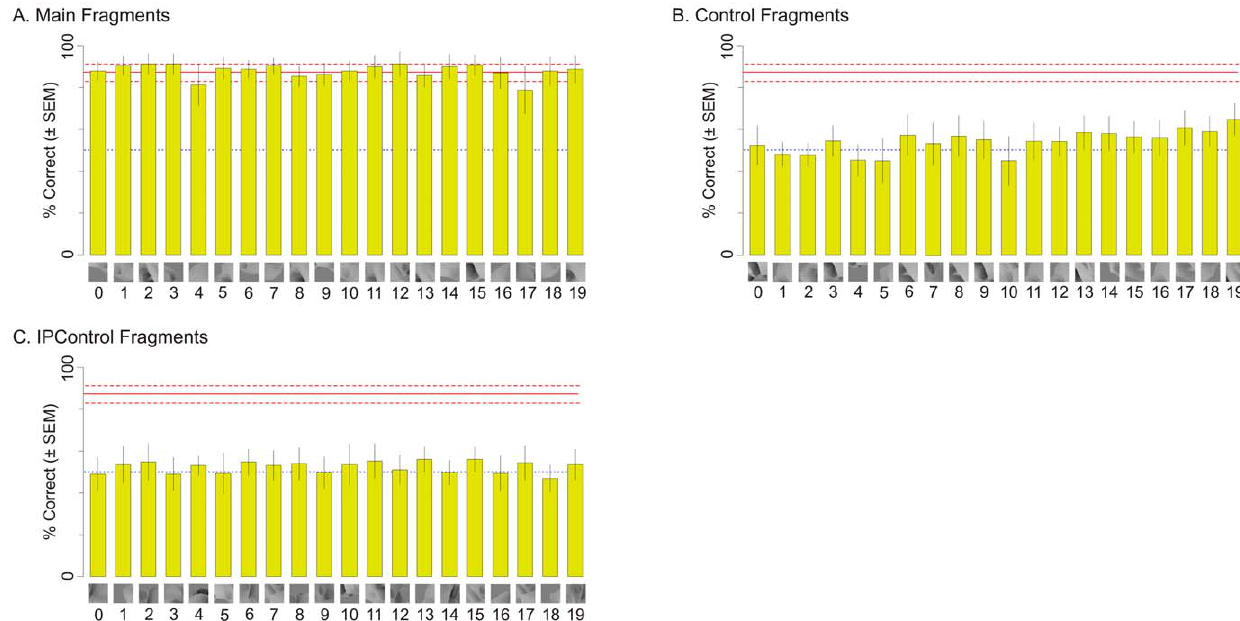
Figure 7. Performance in Experiment 2. Each bar shows the average performance ( 6 SEM) of the animals with a given fragment. The dotted blue line denotes 50%, or chance level performance. The light red lines denote the mean (solid line) and 6 SEM (dashed lines) performance of the animals during the respective last four blocks of training. Panels ( A ), ( B ) and ( C ) show the responses of the animals in the Main task (i.e ., Z vs . X) using Main, Control and IPControl fragments respectively. With each Main fragment, the performance was significantly above chance (binomial tests, p , 0.05), and indistinguishable from the performance using whole objects (binomial tests, p . 0.05, data not shown).